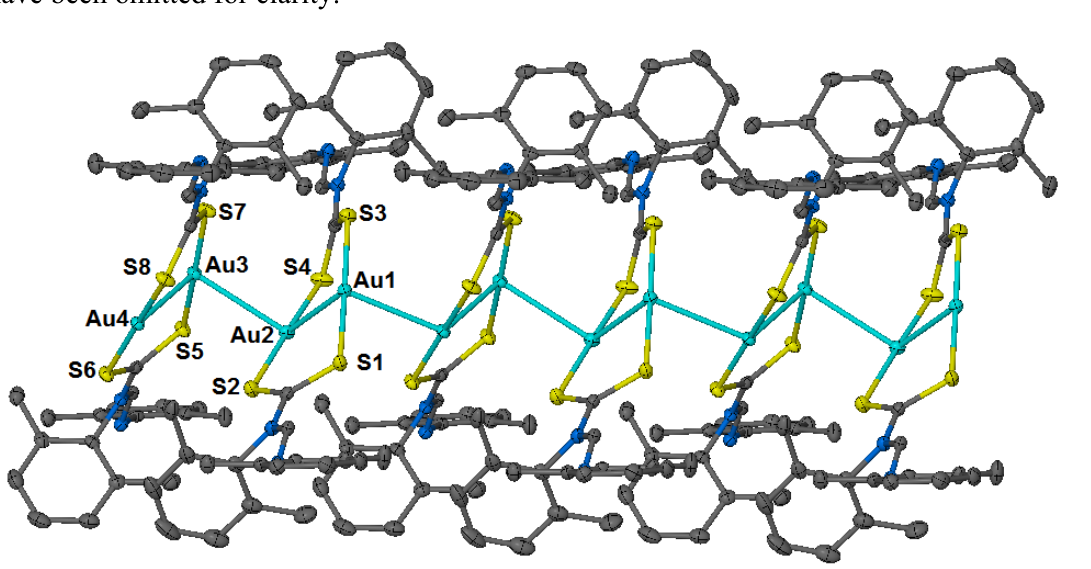
Figure 3. Thermal ellipsoid plot of 4 shown at the 50% probability level. Hydrogen atoms have been omitted for clarity.